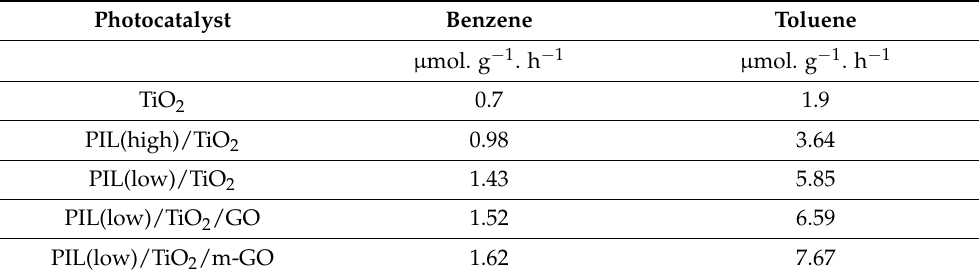
Table 2. Specific catalytic activity of different photocatalysts for benzene and